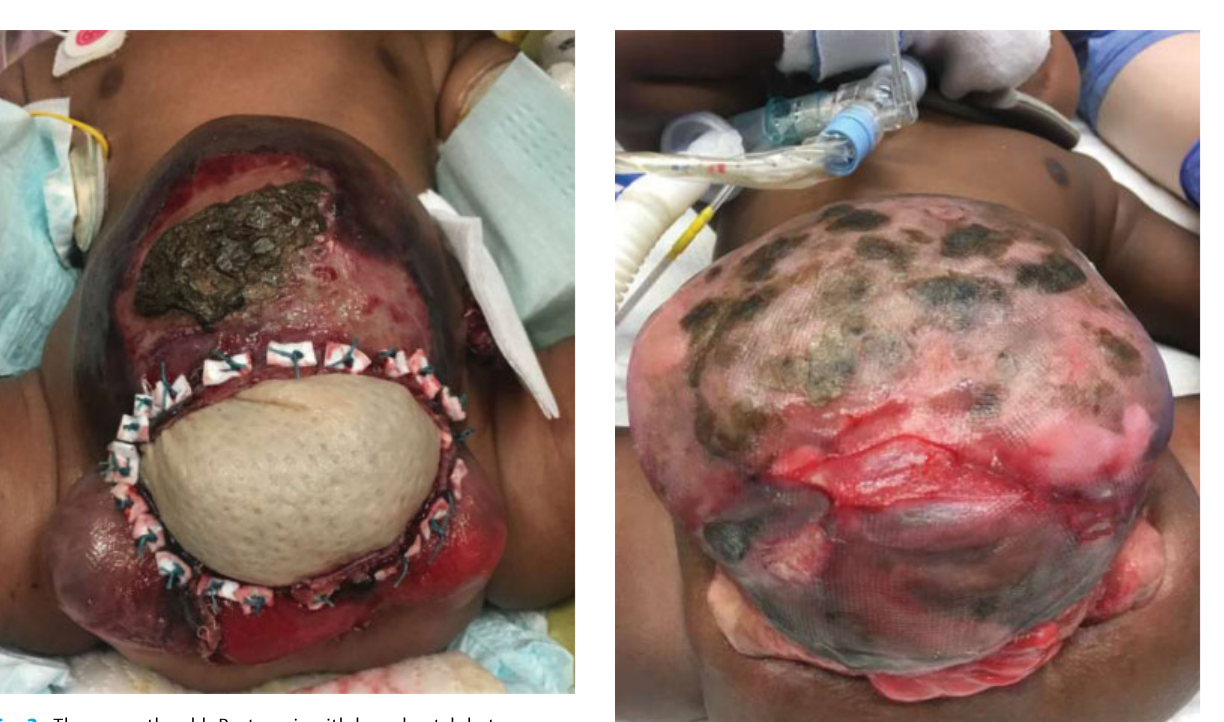
Fig. 3 Three months old: Postrepair with bowel patch between bladder plates and alloderm closure of omphalocele. Ostomy is in the left upper quadrant, under the gauze.